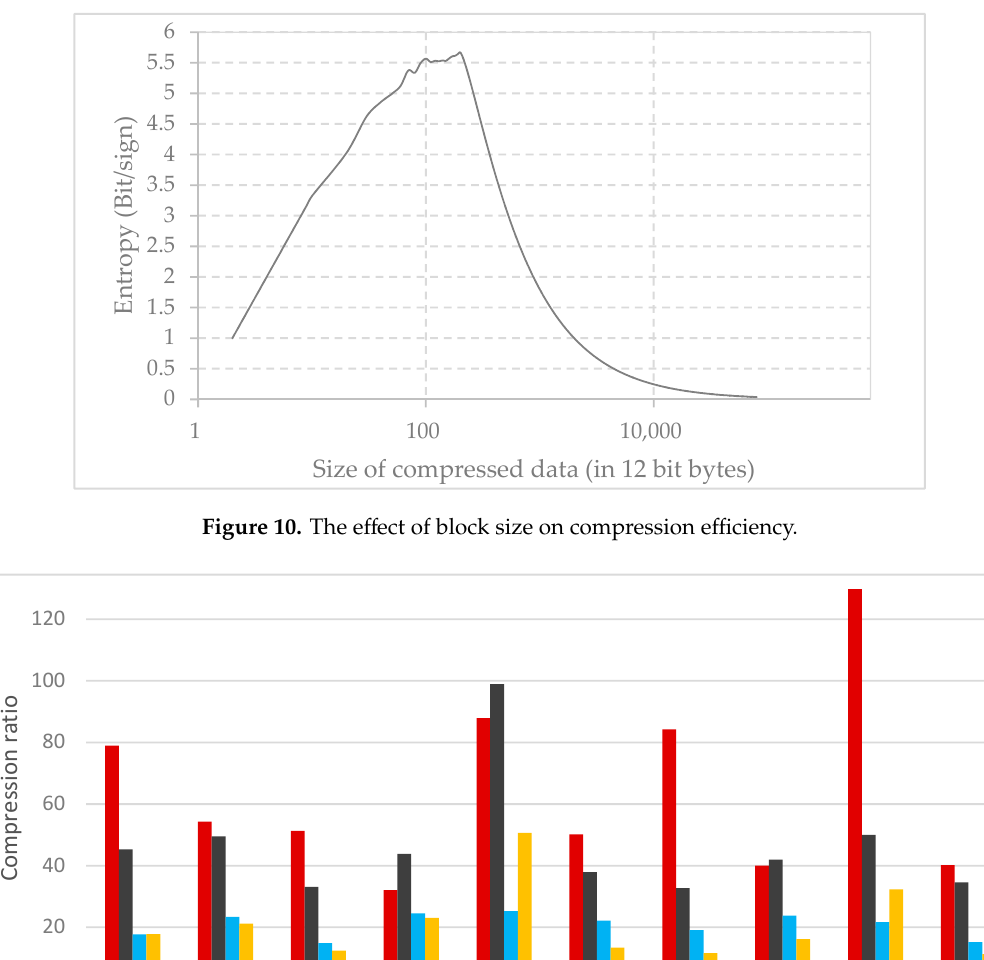
Figure 10. The effect of block size on compression efficiency.